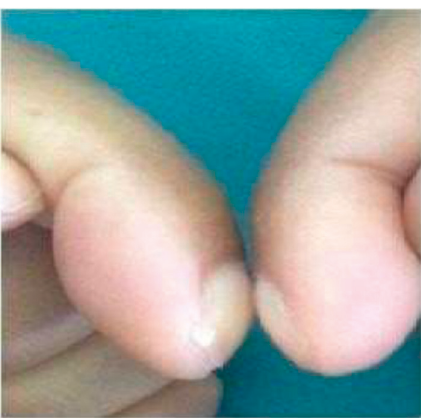
Figure 1: Digital clubbing and positive Schamroth’s